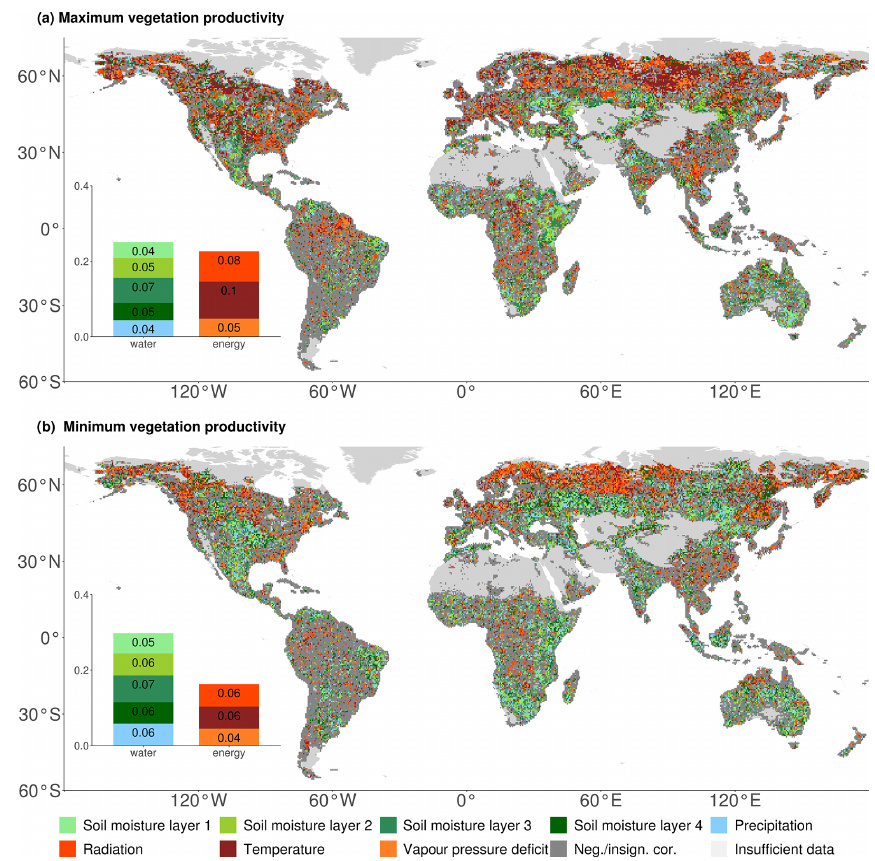
Figure 4. Global distribution of hydrometeorological controls of Sun-induced chlorophyll fluorescence (SIF) (a) maxima and (b) minima in respective colours, as assessed from the strongest correlations. The inset bar plot indicates the area controlled by each variable relative to the total study area. Dark-grey colour denotes the study area in which correlations are